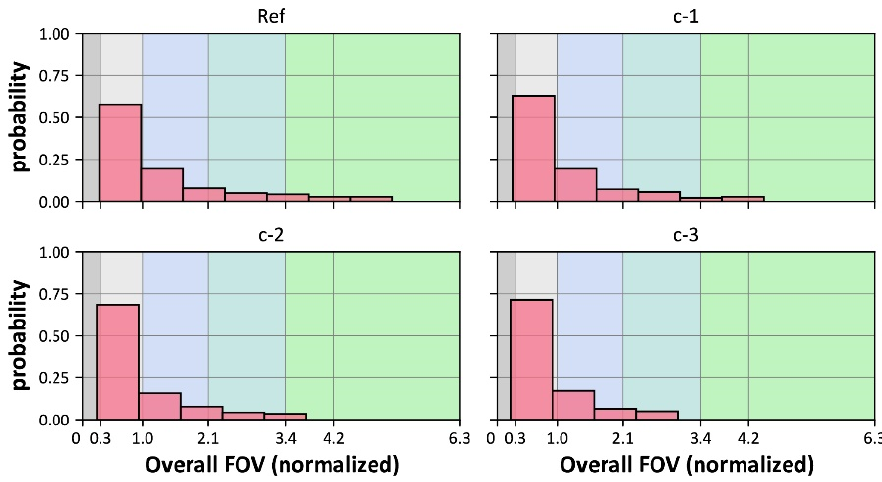
Figure 14. Impacts of external overhangs installed around window edges on the histograms of overall FOVs for scenario-c. including case studies of Ref and c-1 to c-3. View access impacts of overhangs are better characterized by cumulative